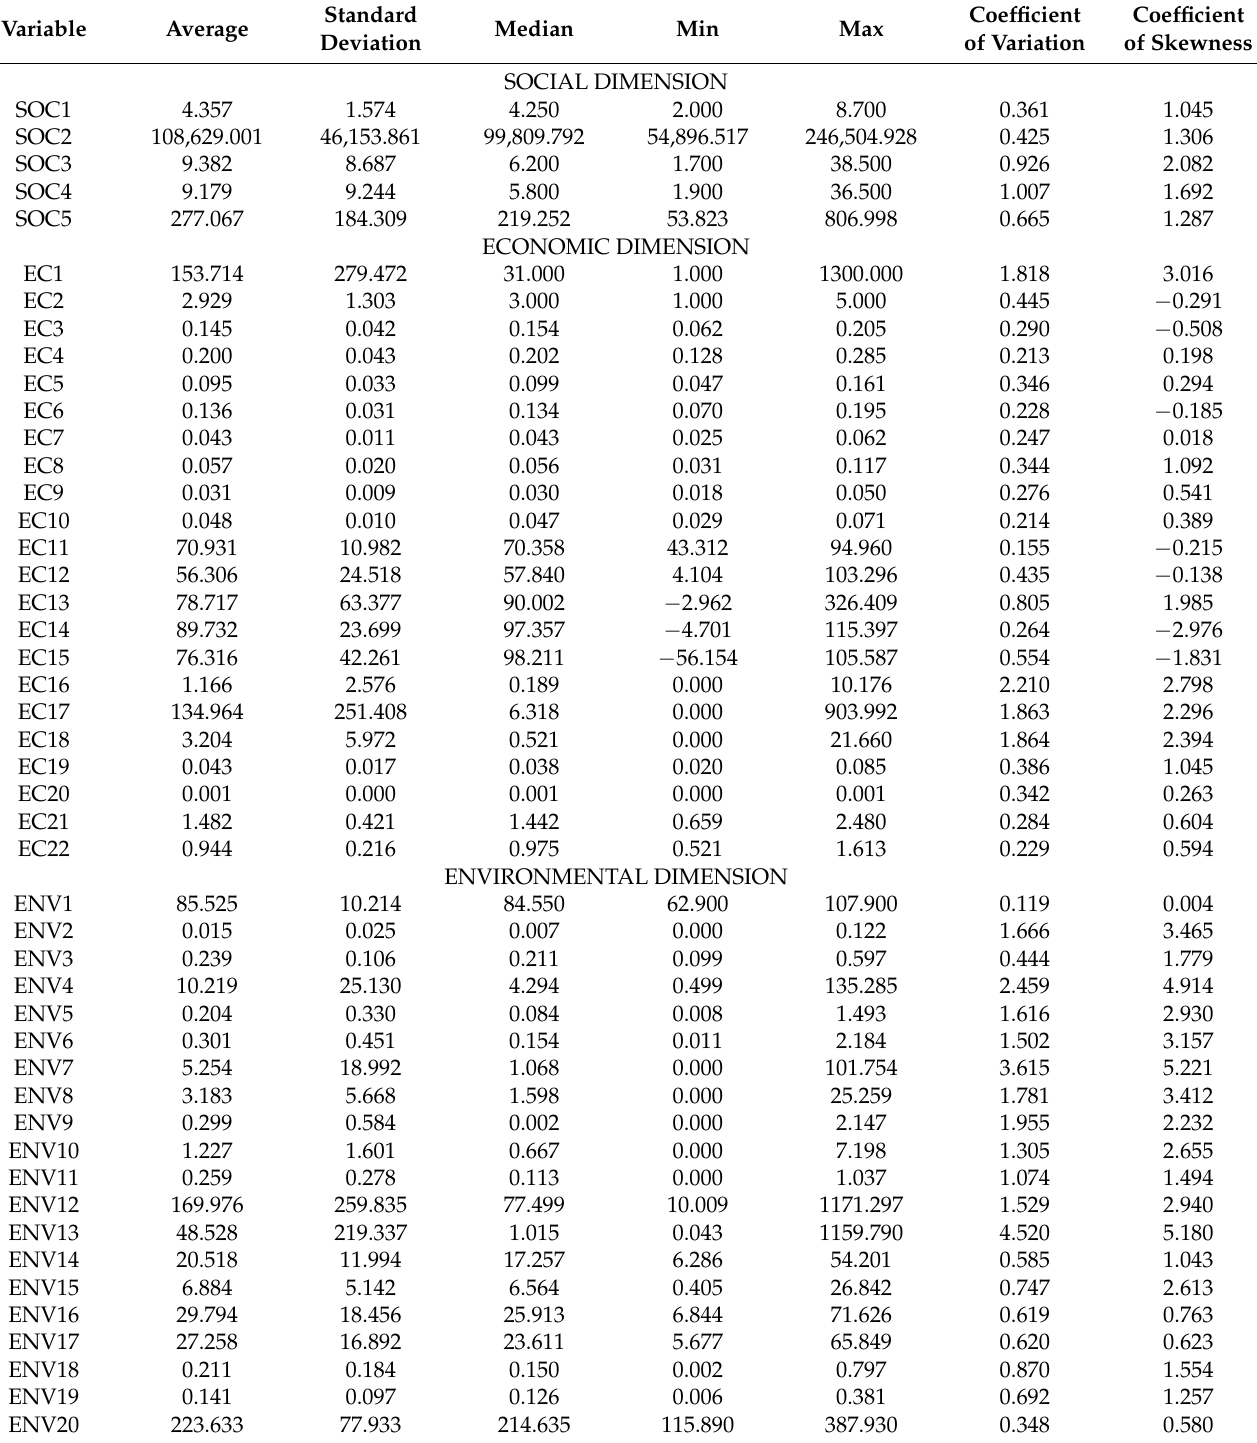
Table 2. Descriptive data analysis for EU-28 Member